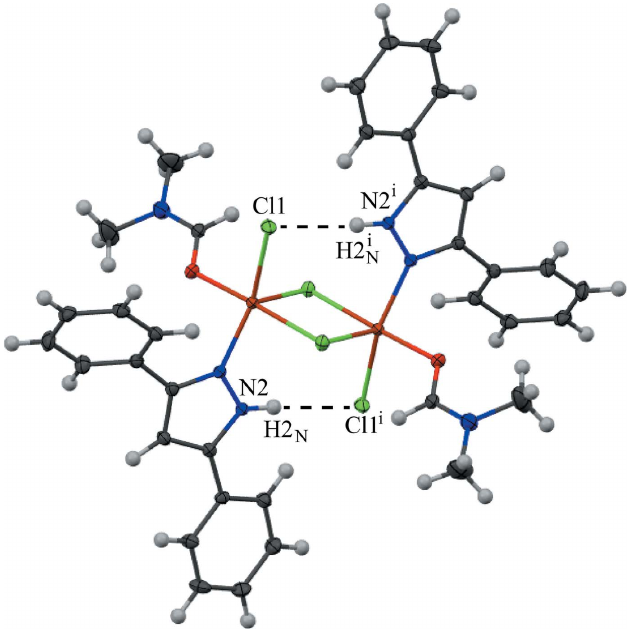
Figure 3 The intramolecular hydrogen bonds present in each molecule of ( 1 ) [symmetry code: (i) (cid:4) x + 1, (cid:4) y + 1, (cid:4) z ]. Hydrogen atoms are displayed in white. See Fig. 1 for additional display